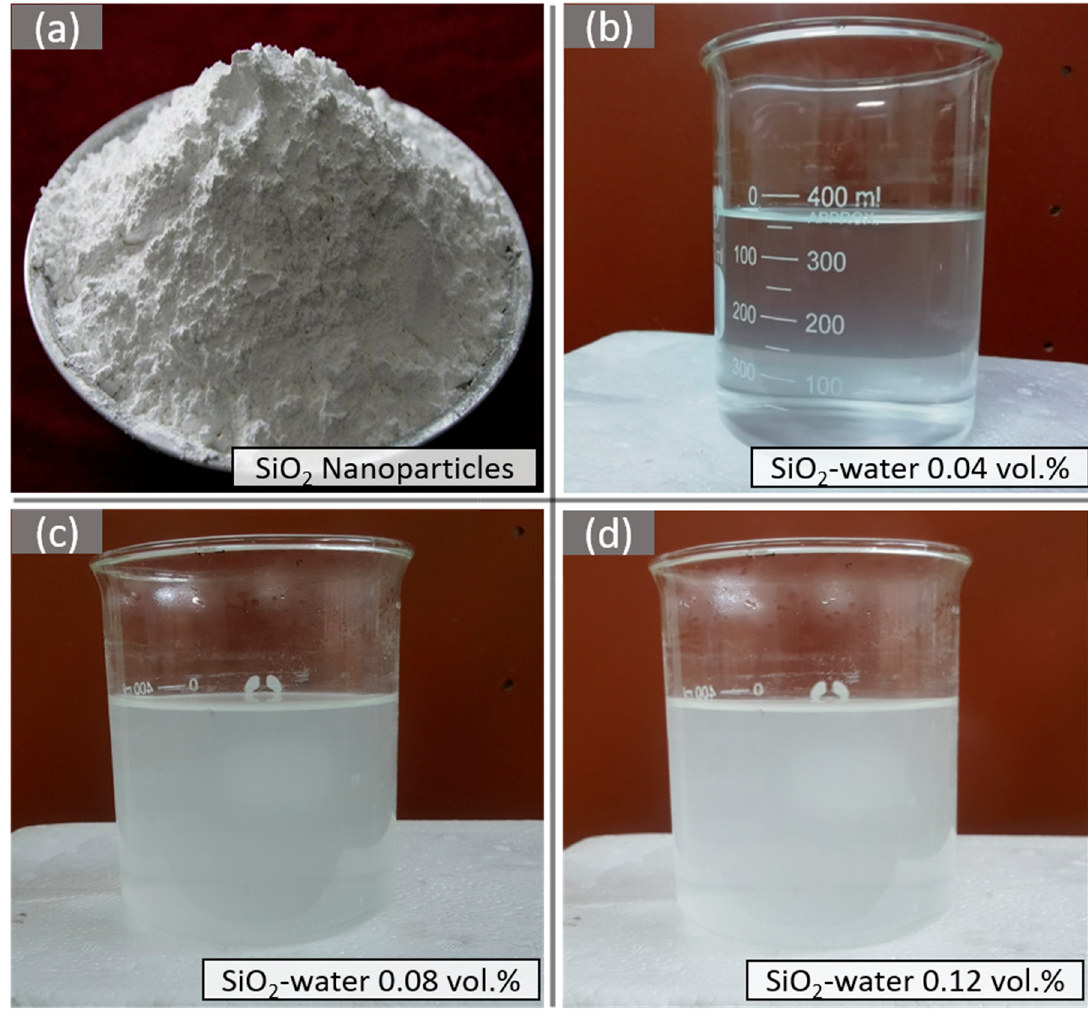
Figure 3. Silica nanoparticles ( a ), SiO 2 –water nanofluid of 0.04 vol.% ( b ), SiO 2 –water nanofluid of 0.08 vol.% ( c ), and SiO 2 –water nanofluid of 0.12 vol.% ( d